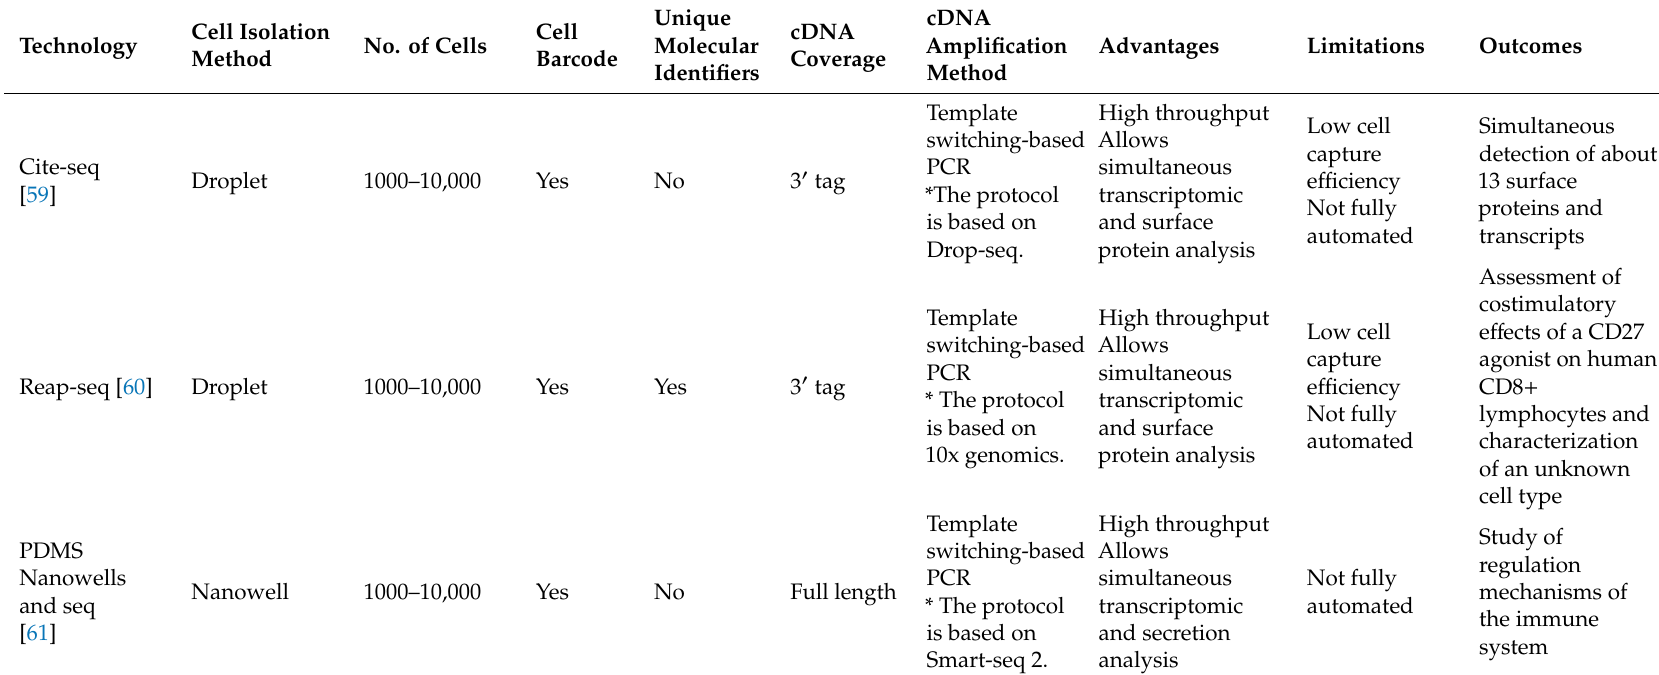
Table 3. Summary of integration of scRNA-seq with protein